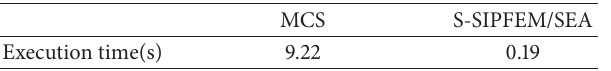
Table 5: Execution times of S-SIPFEM/SEA and the Monte Carlo simulation of the hybrid FE/SEA